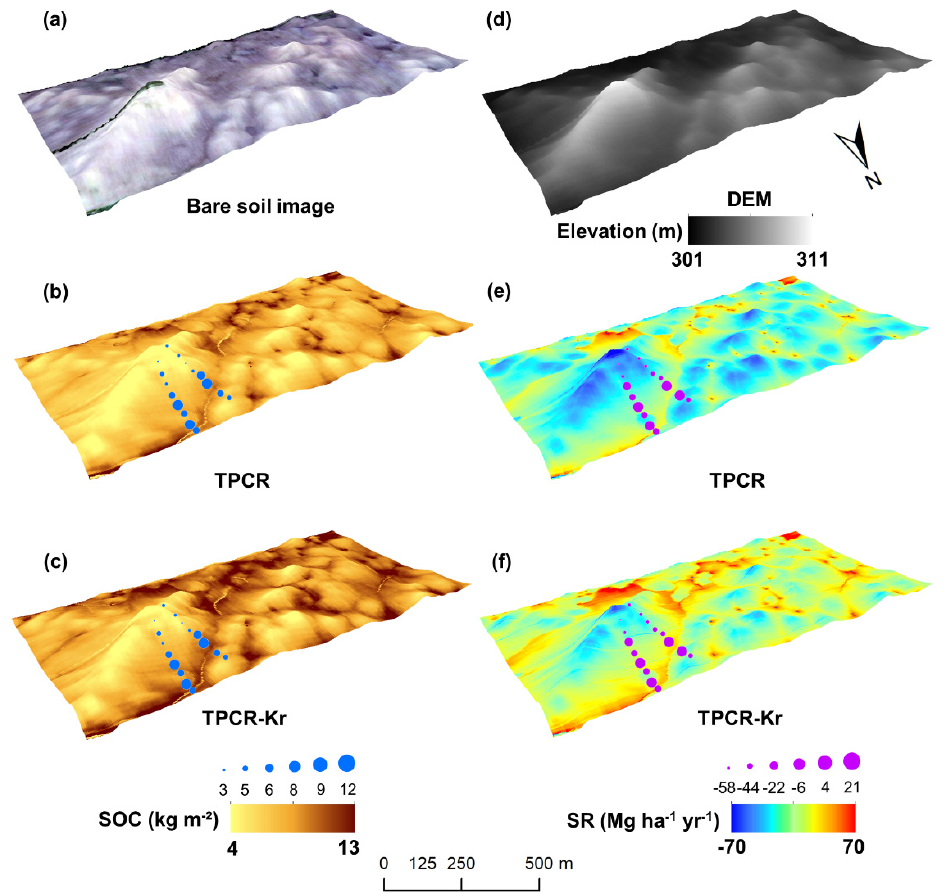
Figure 6. Maps of landscape characteristics and model-derived soil property maps at field site 2: ( a ) bare soil image; ( b ) topographic principal component regression (TPCR)-derived SOC density; ( c ) TPCR-kriging (TPCR-Kr)-derived SOC density; ( d ) elevation; ( e ) TPCR-derived soil redistribution (SR) rate; and ( f ) TPCR-Kr-derived SR rate.